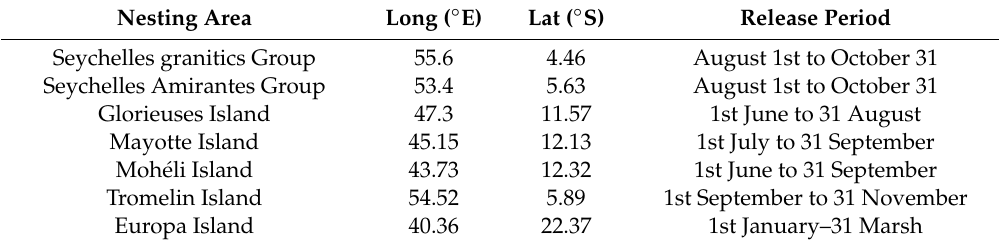
Table 3. Particle simulation release information. Table showing the location of release sites for the particle simulation as well as the release period corresponding with the peak hatching emergence for each